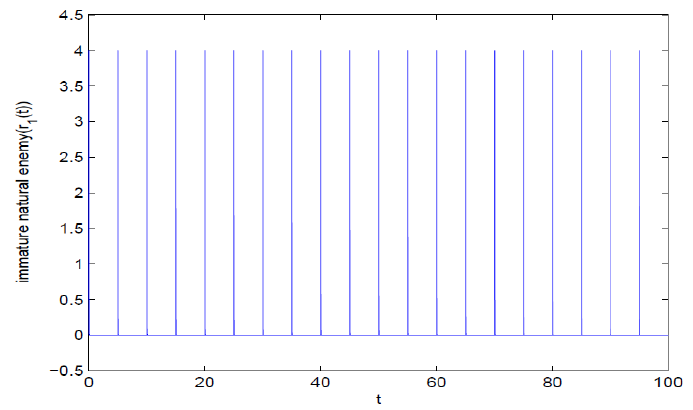
Figure 8. Immature natural enemies (𝑟